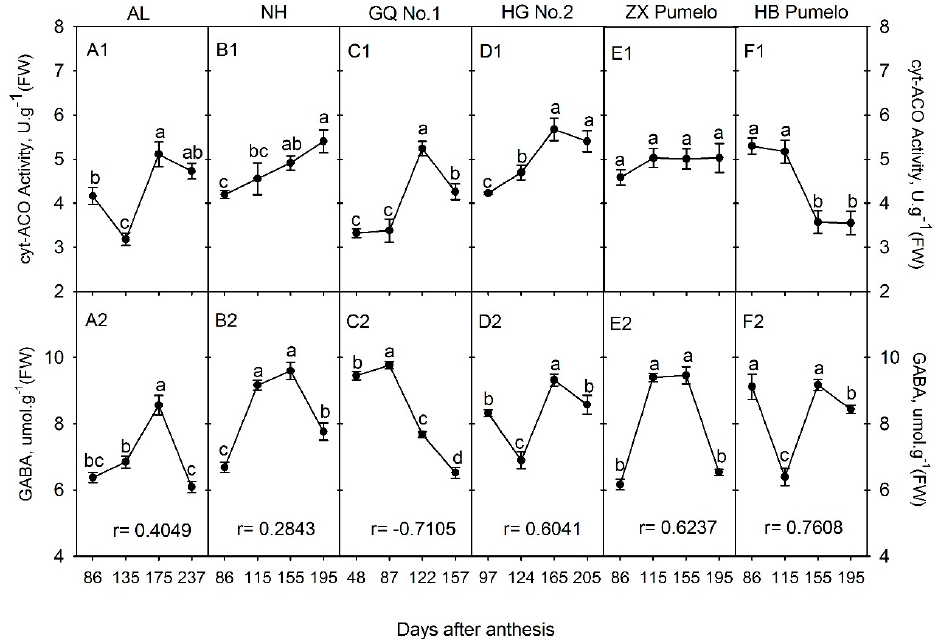
Figure 2. Changes of the cytosolic aconitase (cyt-ACO) activity ( A1~F1 ) and γ -aminobutyric acid (GABA) concentration ( A2~F2 ) in the fruit juice sacs during fruit development and ripening of six citrus cultivars. AL refers to ‘Anliu’ orange. NH refers to ‘Newhall’ navel orange. GQ No. 1 refers to ‘Guoqing No. 1 ′ Satsuma mandarin. HG No.2 refers to ‘Huagan No. 2 ′ ponkan. ZX pumelo refers to ‘Zaoxiang’ pumelo. HB pumelo refers to ‘HB’ pumelo. Different lowercase letters on the bar in each graph indicate significant di ff erences at p < 0.05 among samples at di ff erent stages by Duncan’s multiple range test. r refers to the correlation coe ffi cient between the GABA concentration and the cyt-ACO activity in each cultivar.